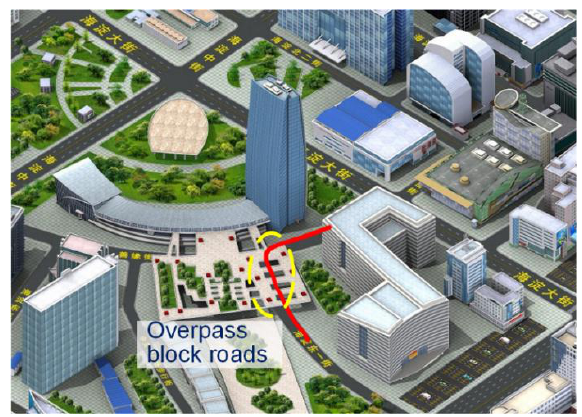
Figure 26. 3D map of roads in the city canyon test.